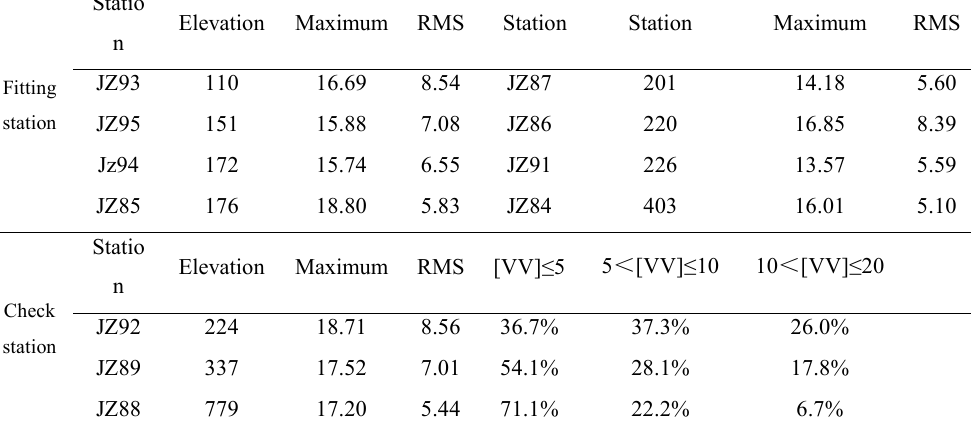
Table 2 zenith tropospheric residual statistics of each station (unit